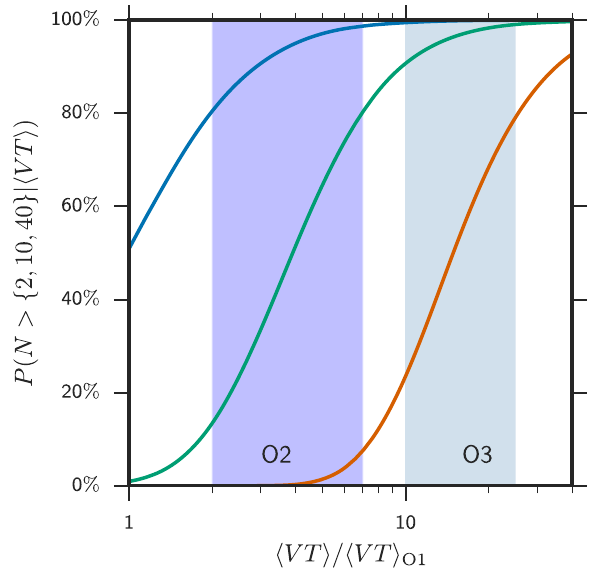
FIG. 13. The probability of observing N > 2 , N > 10 , and N > 40 highly significant events, as a function of surveyed space- time volume, given the results presented here. The vertical line and bands show, from left to right, the expected sensitive space- time volume for the second (O2) and third (O3) advanced detector observing